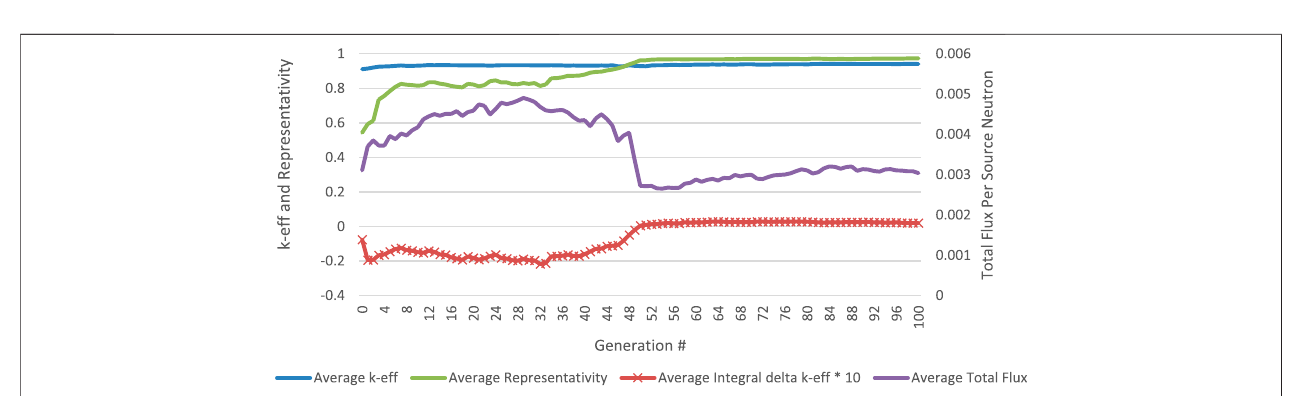
FIGURE 6 | Average objective and constraint evaluation during surrogate NSGA-II optimization for all parents in each generation.